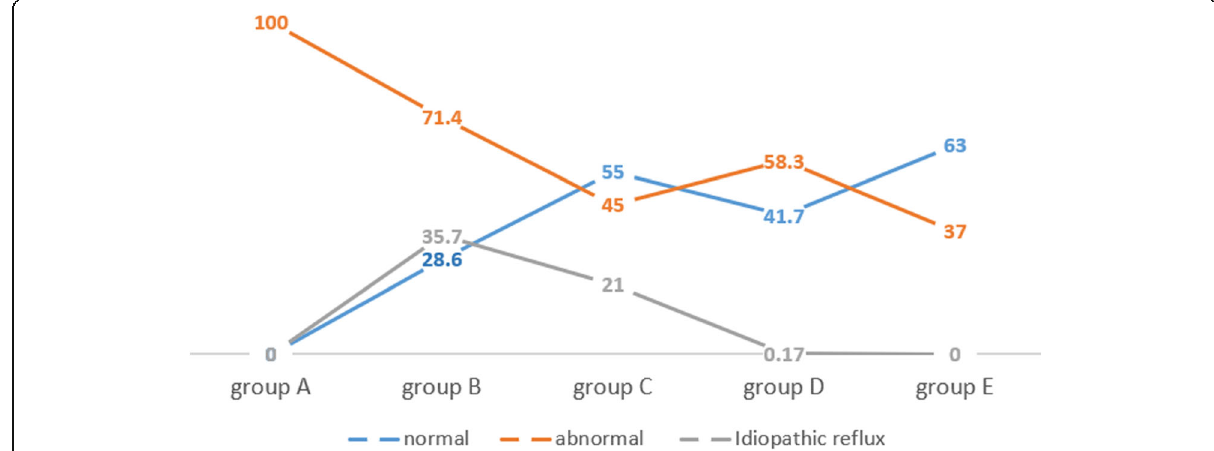
Fig. 1 Diagram illustrating the percentage of normal and abnormal study results in addition to the prevalence of detected idiopathic gastroesophageal reflux in different age groups